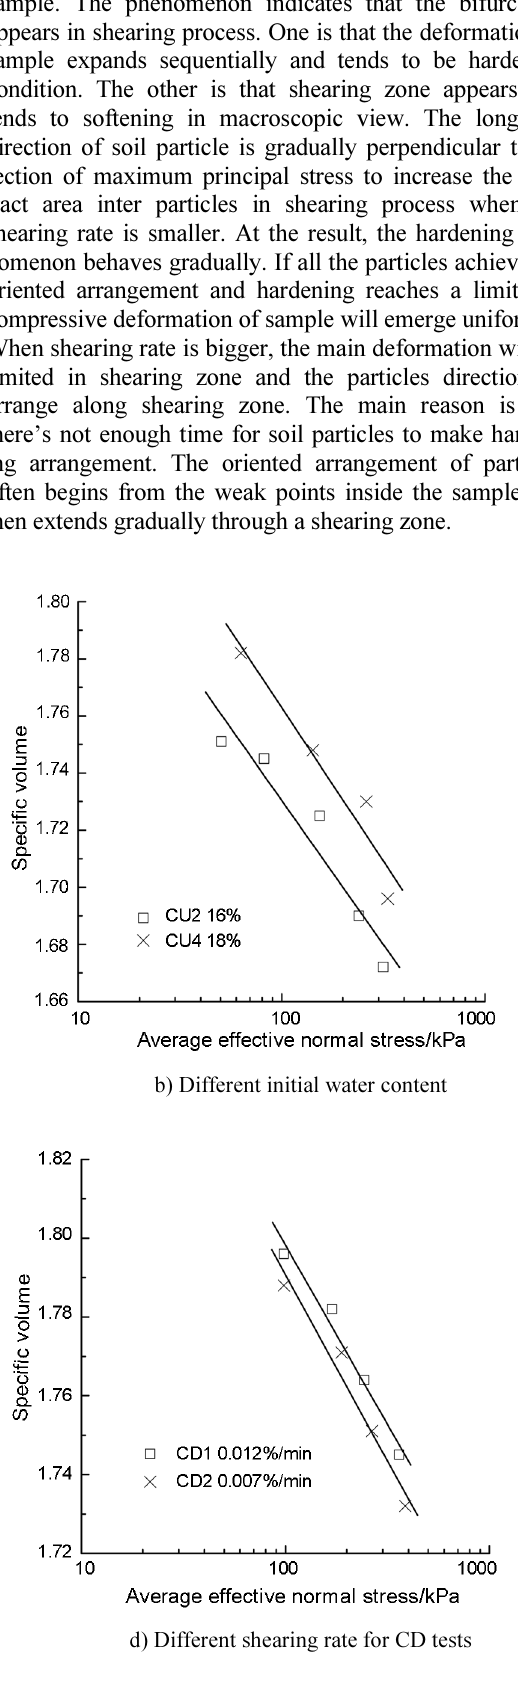
Fig. 2. Relationship between average effective normal stress and specific volume under different